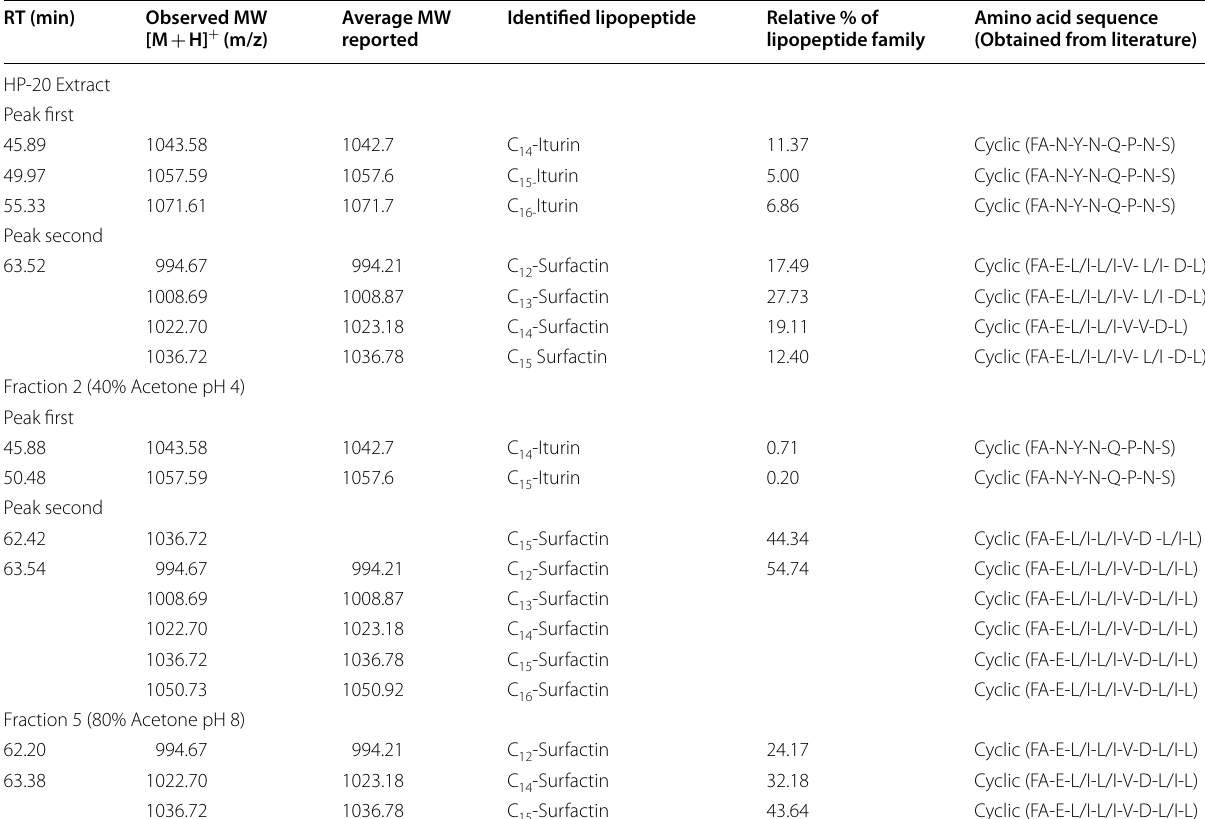
Table 2 LC–ESI–MS identification of surfactin and iturin type of homologues produced by B. velezensis SK , and comparison of their Molecular weight and peptide sequence reported in literature (Dhanarajan et al. 2016; Goswami and Deka 2019; Souza et al. 2018; De Faria et al. 2011; Dang et al. 2019; Liu et al. 2020; Chen et al. 2020)